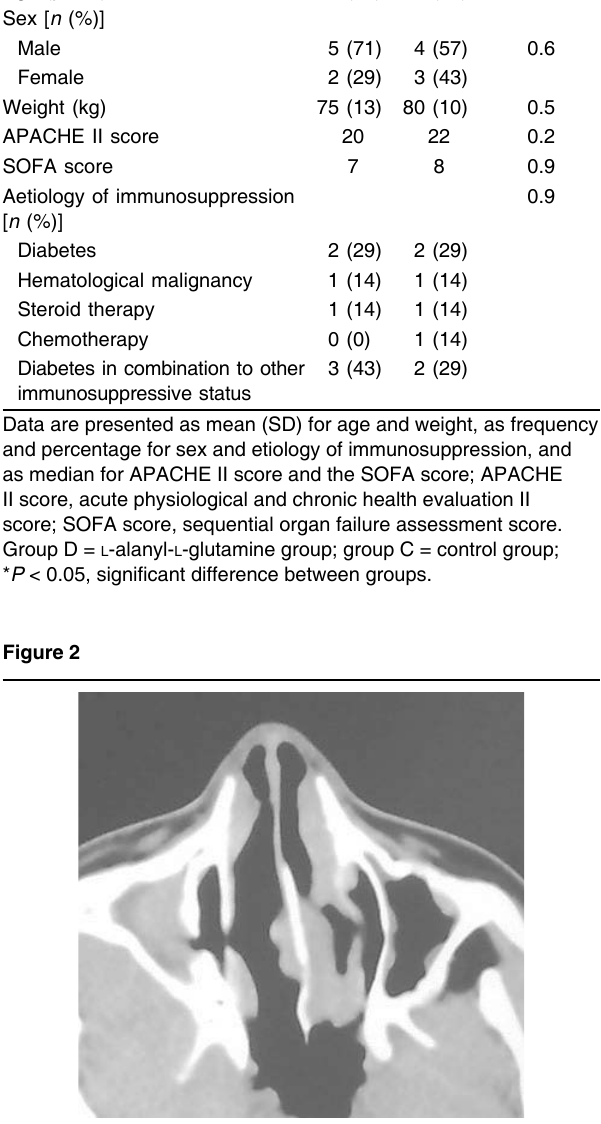
Coronal computed tomography PNS soft-tissue window showing erosion of the left lamina papyracea with fungus extending into the orbit with septal perforation and left maxillary sinus affection .